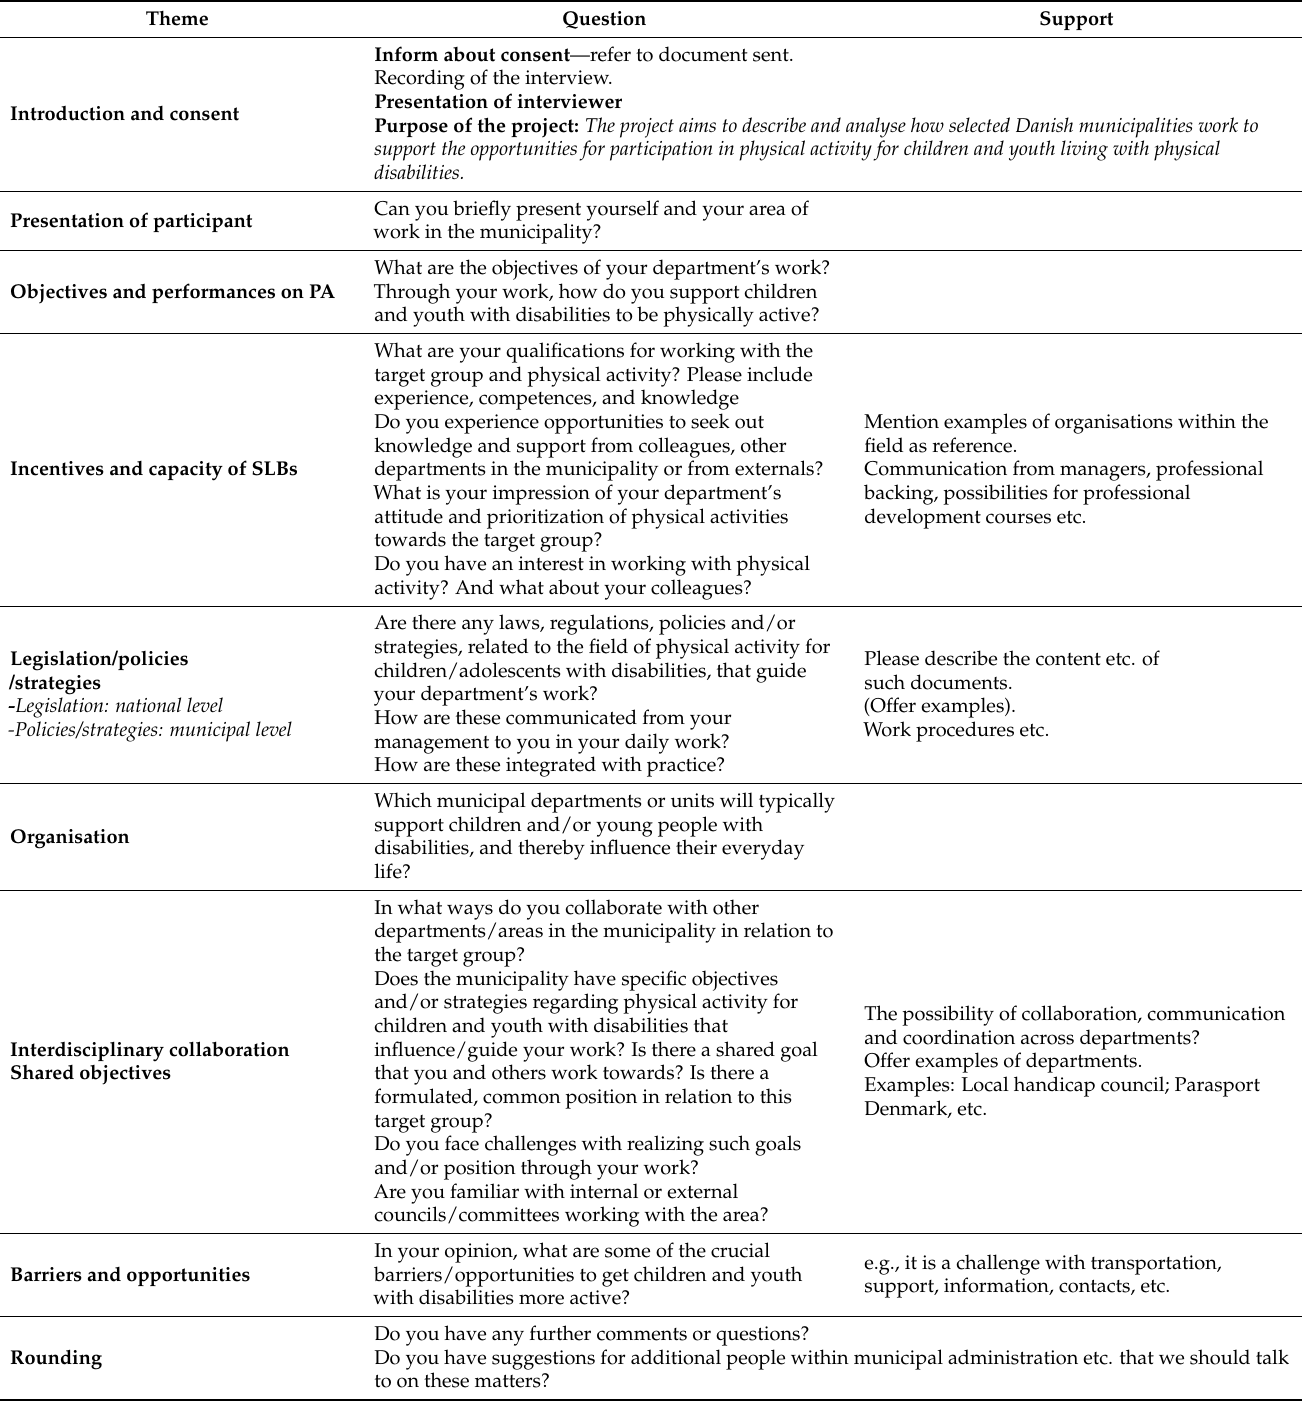
Table A1. Interview guide,